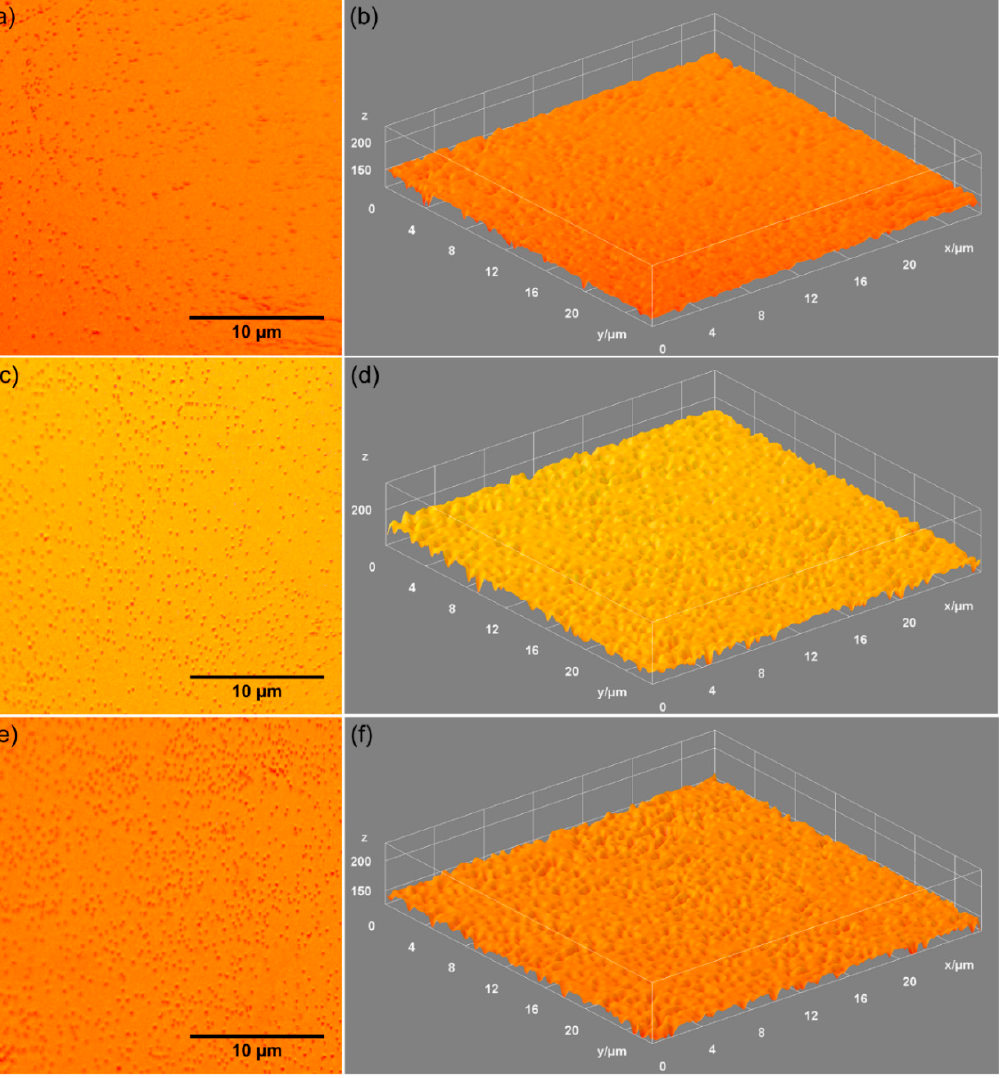
Figure 4. 2D Metallographic images (taken using 10× magnification) of HAp ( a ), 0.05 AgHAp ( c ), and 0.1 AgHAp ( e ) coatings, and 3D representation of the metallographic images of HAp ( b ), 0.05 AgHAp ( d ), and 0.1 AgHAp ( f ) coatings.